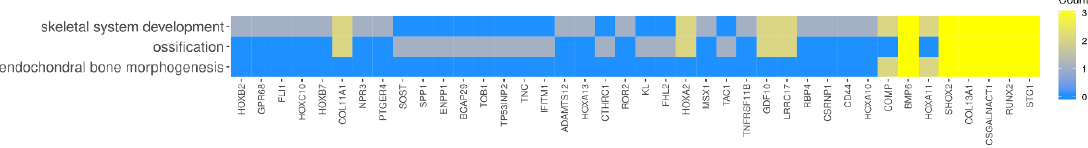
Figure 4. Heatmap showing the gene occurrence between genes that belong to “endochondral bone morphogenesis”, “ossification”, and “skeletal system development” GO BP terms. The yellow color indicates the gene occurrence in indicated GO BP terms. The intensity of the color correlates with the number of GO BP terms to which the selected gene belongs.